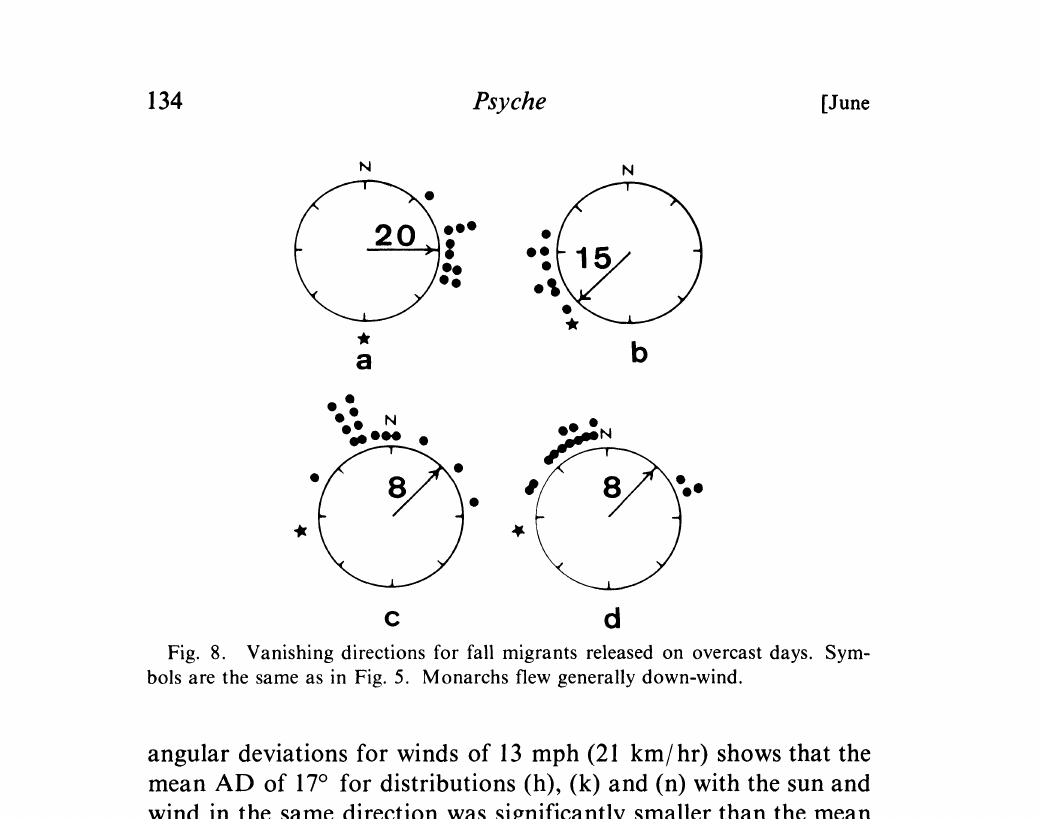
Fig. 8. Vanishing directions for fall migrants released on overcast days. Sym- bols are the same as in Fig. 5. Monarchs flew generally